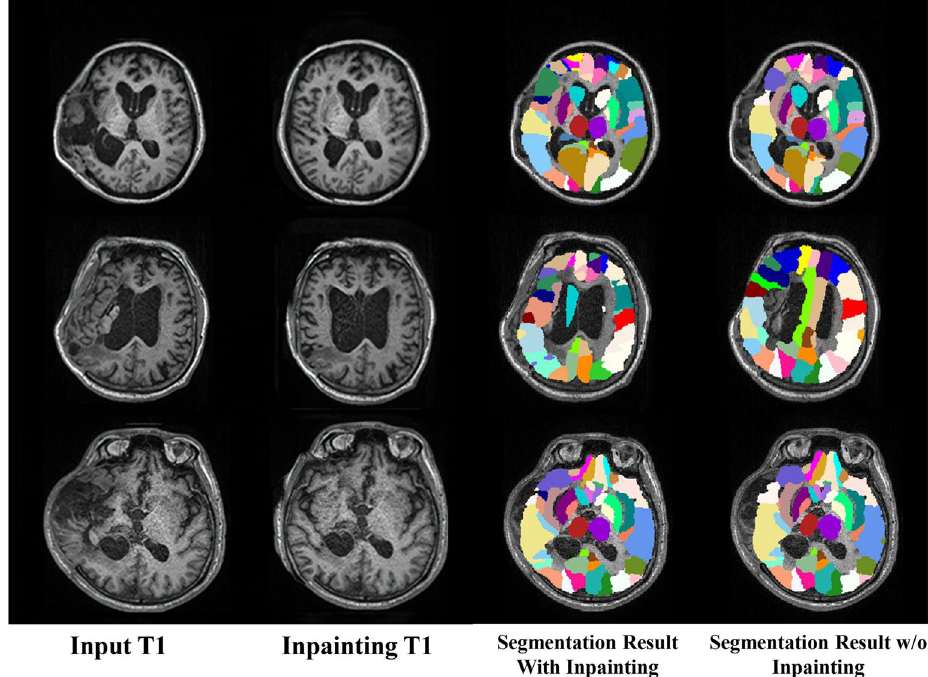
Fig. 5 Segmentation result. From left to right are the input T1 images, inpainted results, and segmentation results with and without inpainting